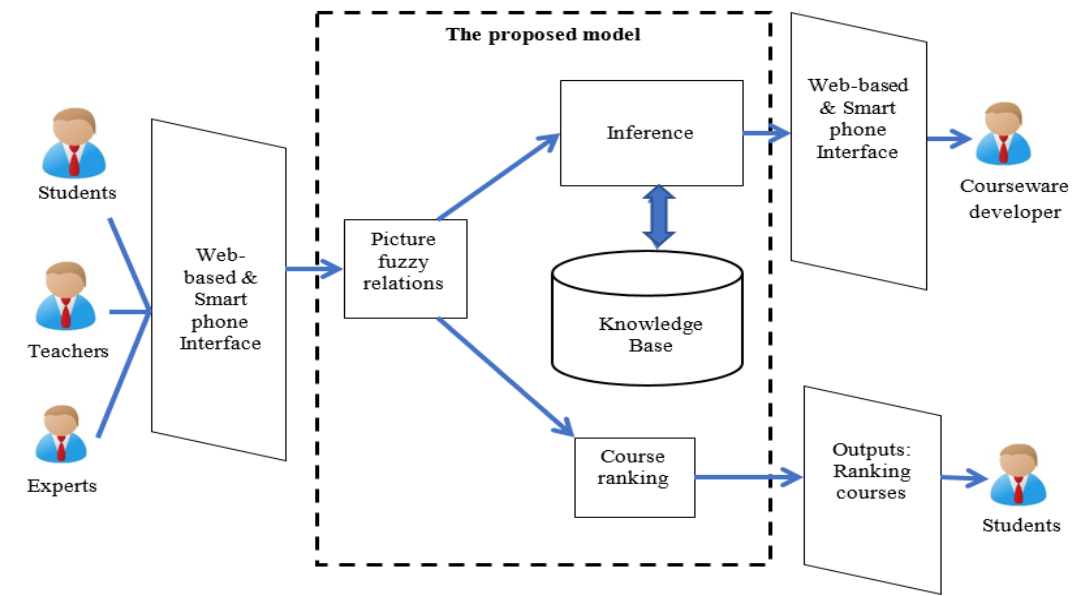
Figure 1. The proposed Pedagogic